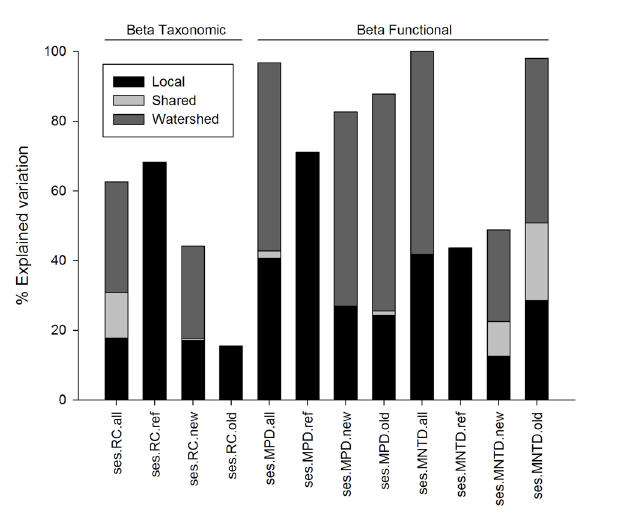
FIGURE 4 | Explained variation of environmental contribution in turnover metrics partitioned by MRM and associated commonality analysis into pure local, shared and pure catchment components. RC = Raup-Crick; MPD = mean pairwise distance; MNTD = mean nearest taxon distance; all = all sampled streams; ref = streams with forested watersheds; new = streams with recently deforested watersheds; old = streams with historically deforested